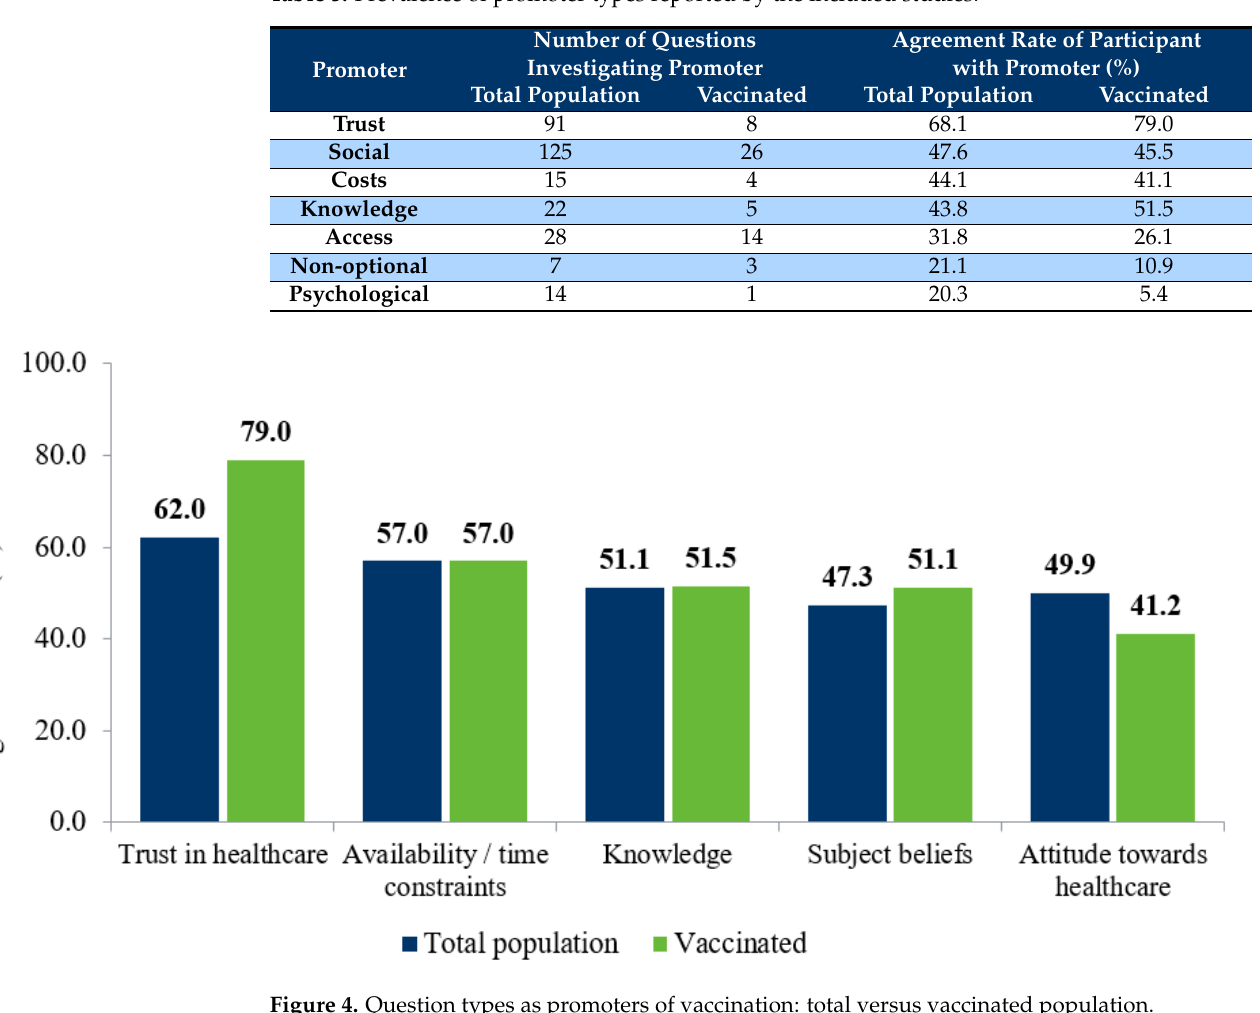
Table 5. Prevalence of promoter types reported by the included studies.